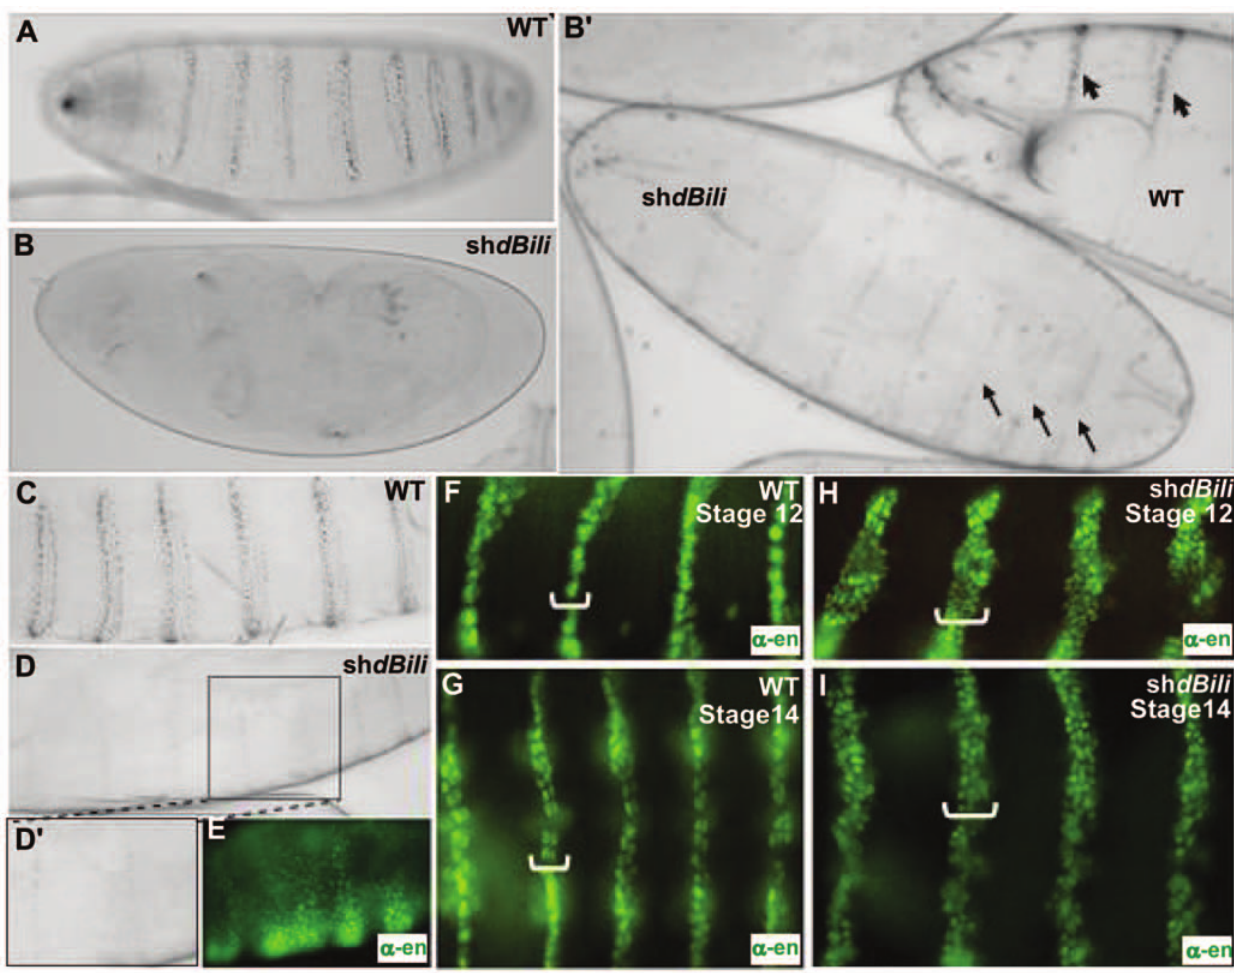
Figure 2. Expansion of wg signaling activity in embryos (ventral view) with diminished levels of dBili. (A) Cuticle preparation of WT control embryo displaying wild type patterning of the embryonic epidermis with uniformly spaced denticle belts. (B) Cuticle preparation of embryo expressing shRNA targeting dBili (shdBili). (B’) WT and shdBili expressing embryos showing a weaker phenotype (black arrows). (C & D) High magnification view of A & B, respectively. D’ & E show boxed region in D. (E–I) Engrailed (En) protein expression. (F & G) Expression of engrailed in WT embryos is restricted to one or two cell-layers in the epidermis during early stage 12 (germband retraction) and in the ventral epidermis at stage 14 (onset of head involution and dorsal closure). (H & I) En expression in shdBili stage-matched embryos (compare with F &